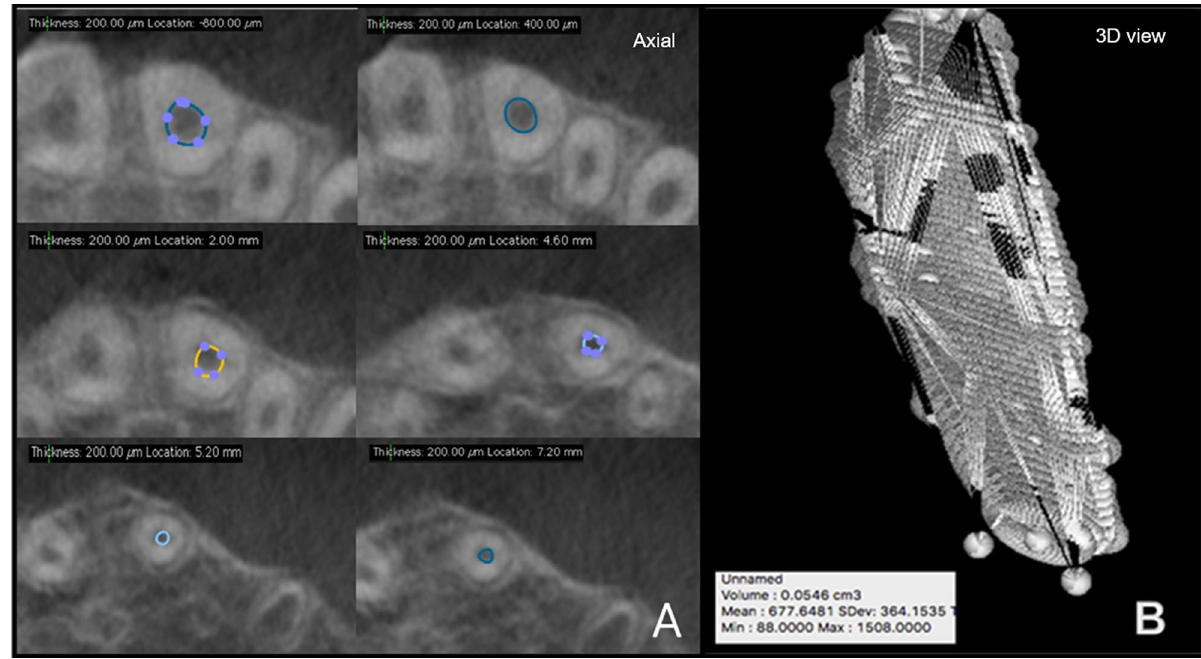
Figure 2. Pulp space volume assessment using OsiriX MD ( A) illustrates the ROI in various axial slices and (B) reconstructed 3D model along with the volume statistics.